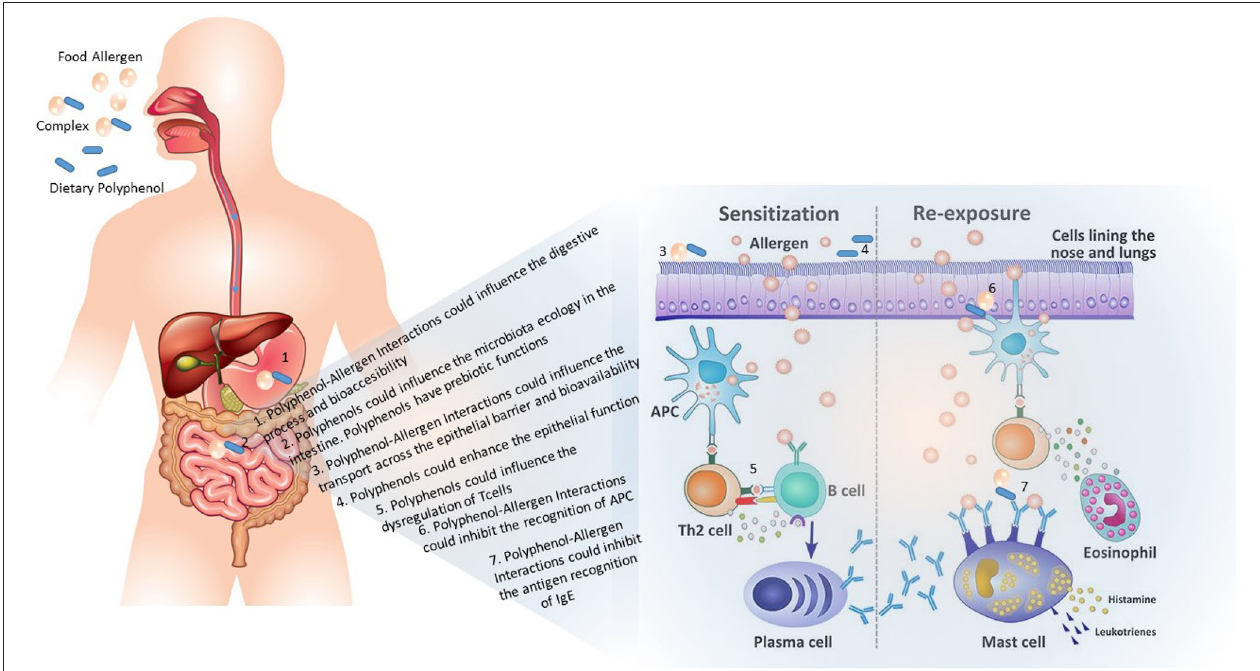
FIGURE 3 | Schematic representation on the polyphenol mechanisms to modulate the immune response in food allergy.